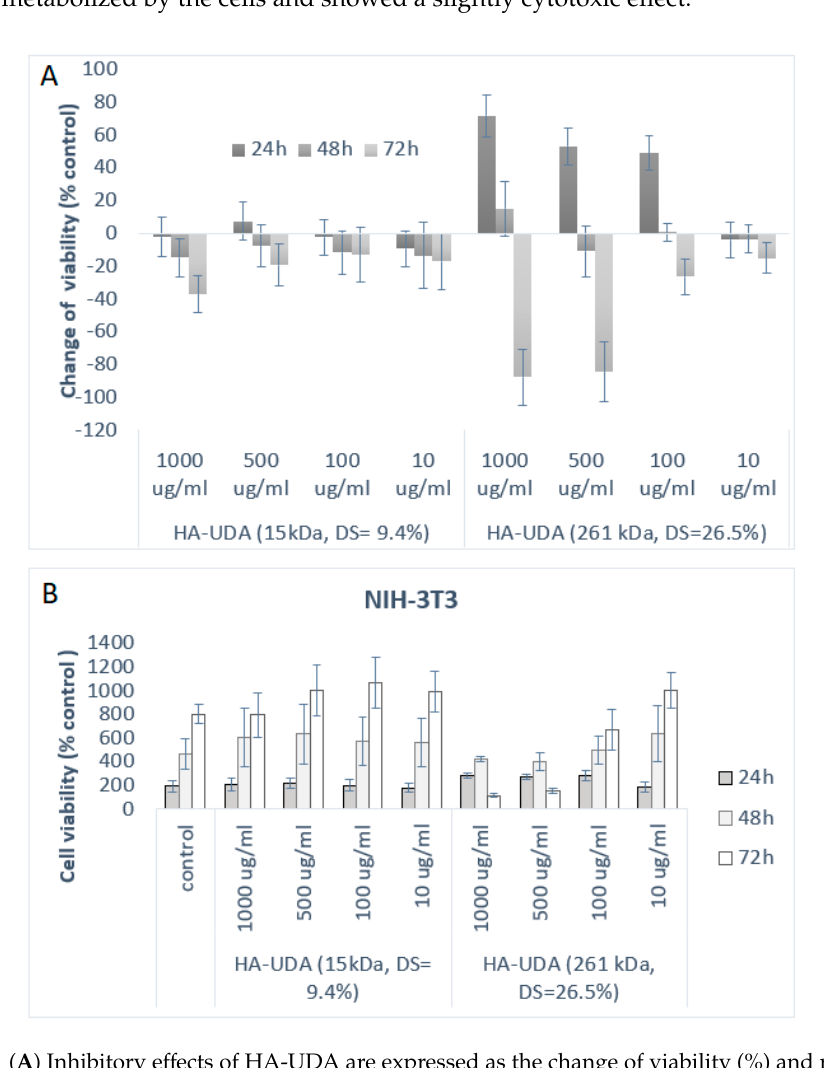
Figure 6. ( A ) Inhibitory effects of HA-UDA are expressed as the change of viability (%) and represent the mean ± SEM of four individual experiments as a function of time ( B ) and cell viability in respect to control for HA-UDA.